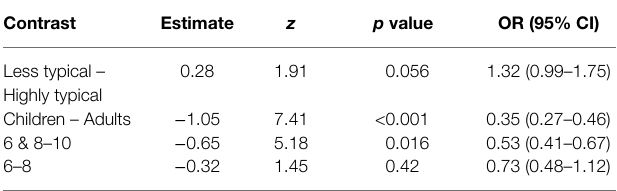
TABLE 3 | Contrasts following the generalized mixed model on accuracy in Experiment 1 for Type of item and Age group. Contrast